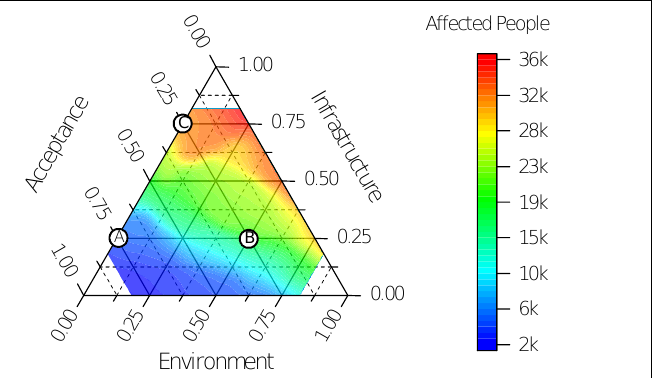
Figure 7. Influence of different weighting factors on the affected people for the DC GER project. Own illustration.